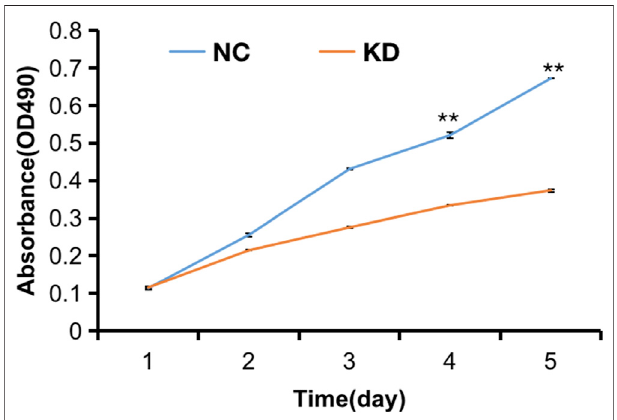
( Figure 10 ) which was in consistent with the result of CCK8 assay ( Figure 11 ). The effect of hsa_circ_0005505 on apoptosis of HBVSMCs was also analyzed. The result of apoptosis analysis suggested that knockdown of hsa_circ_0005505 signi fi cantly promotes HBVSMCs apoptosis ( Figures 12 , 13 ). Besides, the Wound-healing assay demonstrated that hsa_circ_0005505 silencing signi fi cantly impeded HBVSMCs migration ( Figure 14 ).